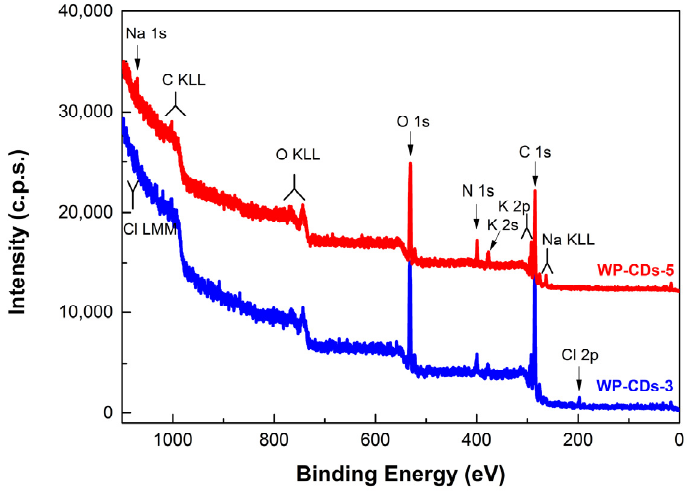
Figure 3. Wide XPS spectra of WP-CDs-3 and WP-CDs-5. Spectra intensities were offset for clarity’s sake.